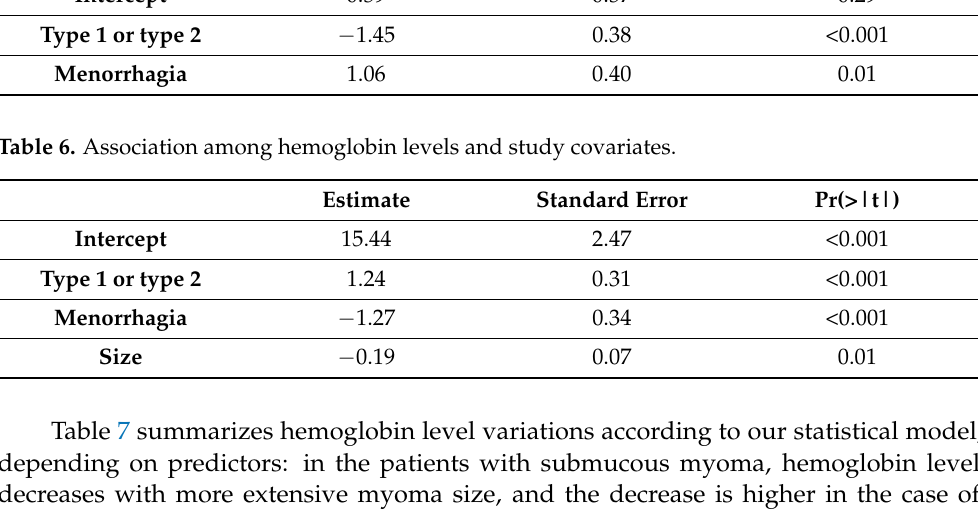
Table 5. Multivariate logistic regression analysis among predictor variables associated with anemia. Estimate